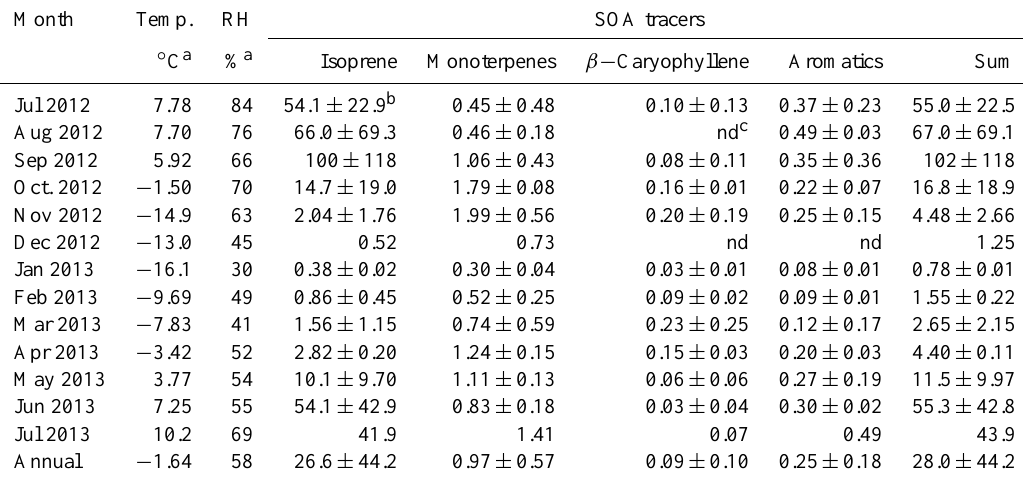
Table 1. SOA tracers at the NC site (ng m − 3 ). Month